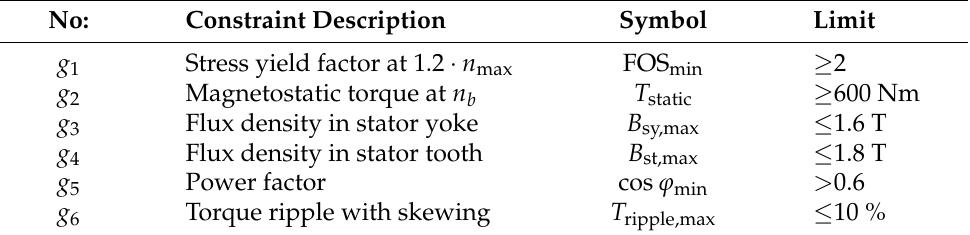
Table 5. List of inequality